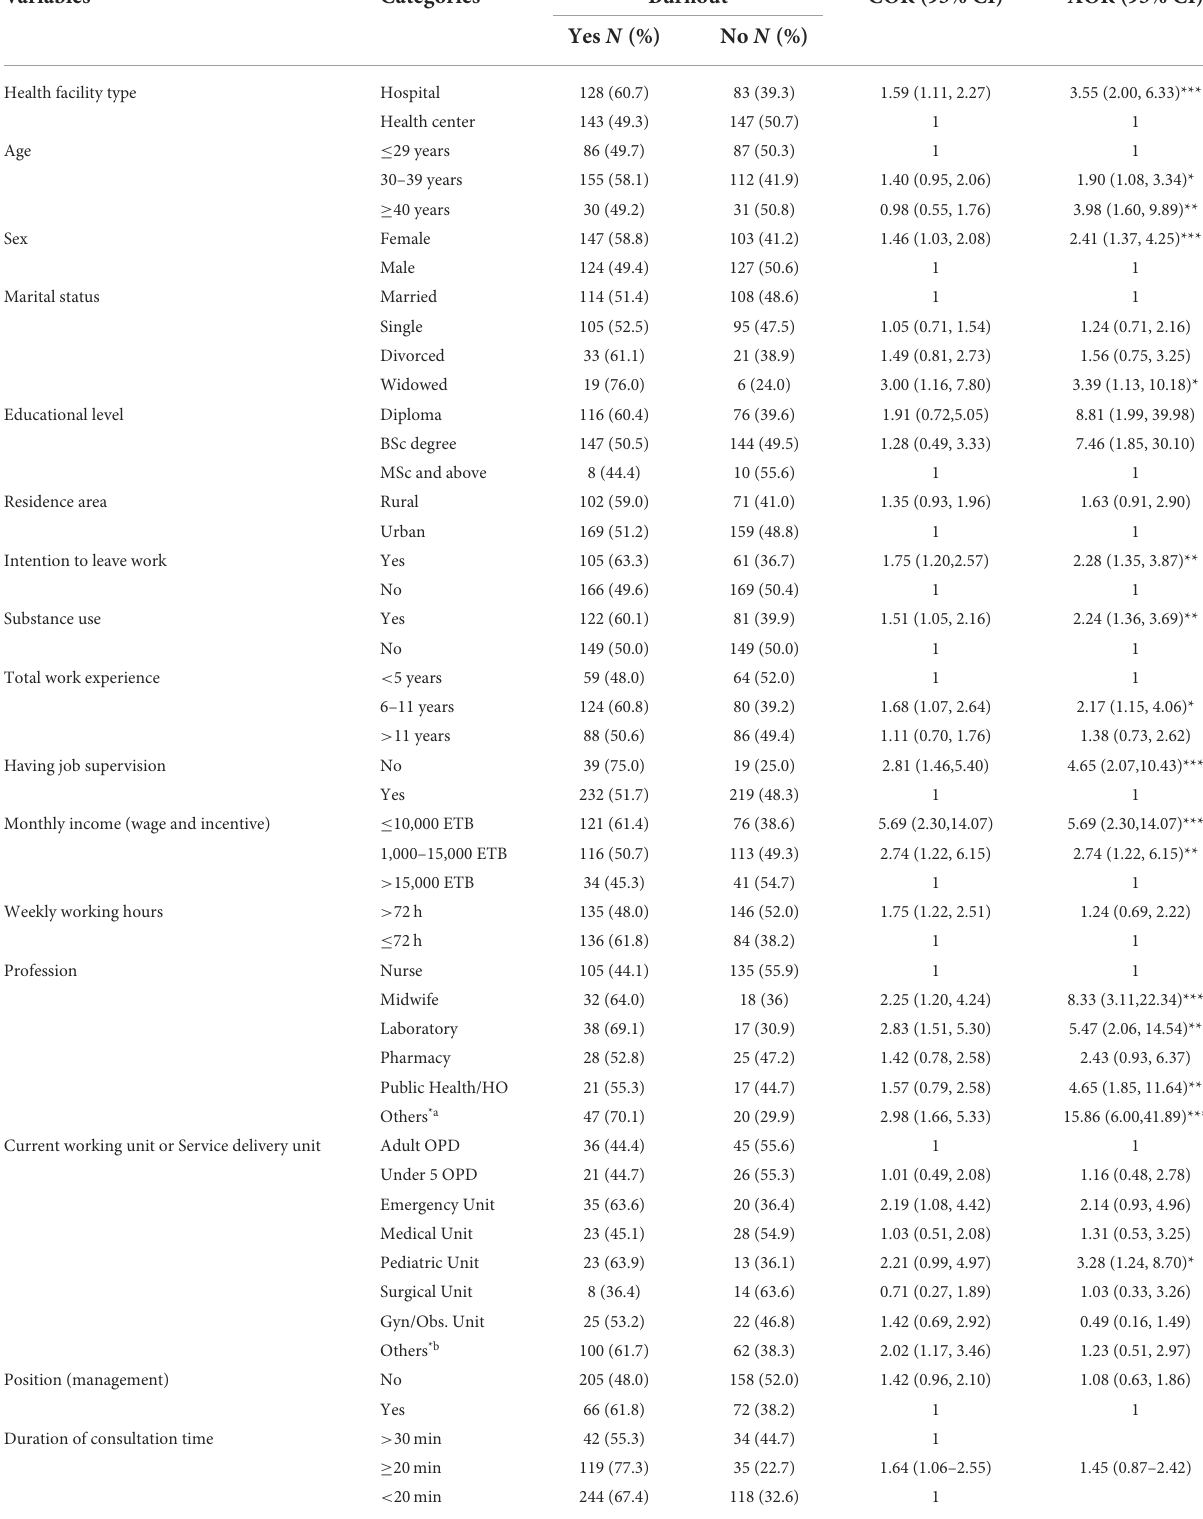
TABLE 3 Multivariable logistic regression of factors associated with burnout of healthcare professionals working at public health facilities of Dire Dawa City, Eastern Ethiopia, 2020 ( n =